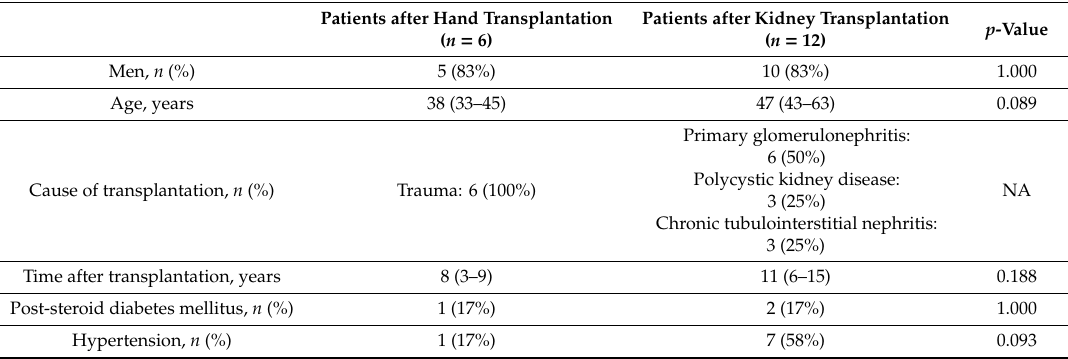
Table 1. Patients’ characteristics.